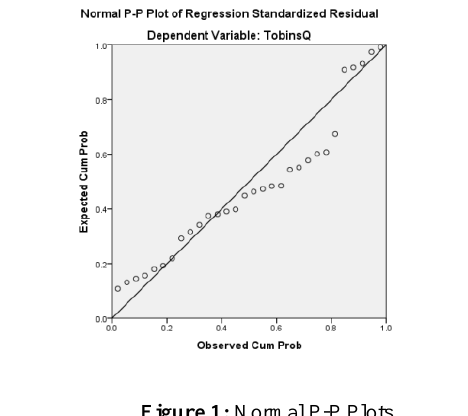
Figure 1: Normal P-P Plots